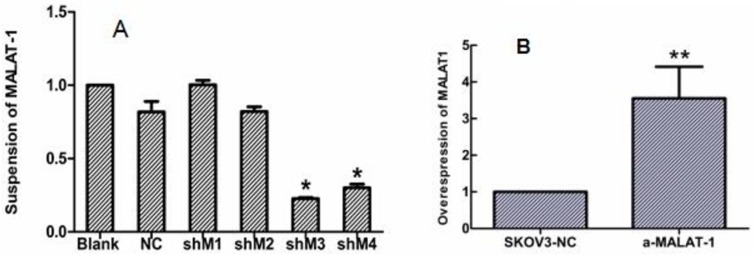
qRT-PCR analysis of MALAT-1 expression in transfected ovarian cells.(A) qRT-PCR analysis of MALAT-1 expression following shRNA knockdown. OVCAR3 cells were grown and transfected with four different MALAT-1 shRNA vectors (shM1 to shM4) and then subjected to qRT-PCR analysis. *p < 0.05 versus control groups.(B) SKOV3 cells were grown and transfected with pcDNA3.1 (+)- MALAT-1 and pcDNA3.1(NC) and subjected to qRT-PCR analysis, *p < 0.05 versus control groups.